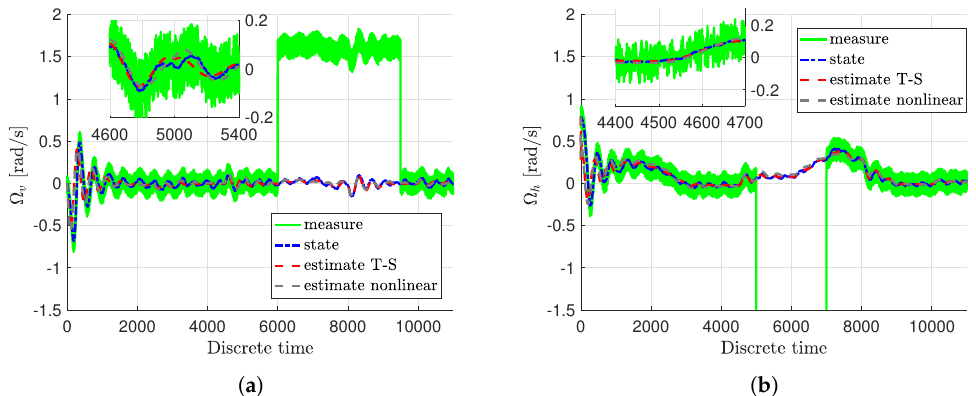
Figure 2. Comparison between nonlinear and Takagi-Sugeno response of the system: angular velocity of the main rotor Ω h ( a ) and angular velocity of the tail rotor Ω v ( b ).